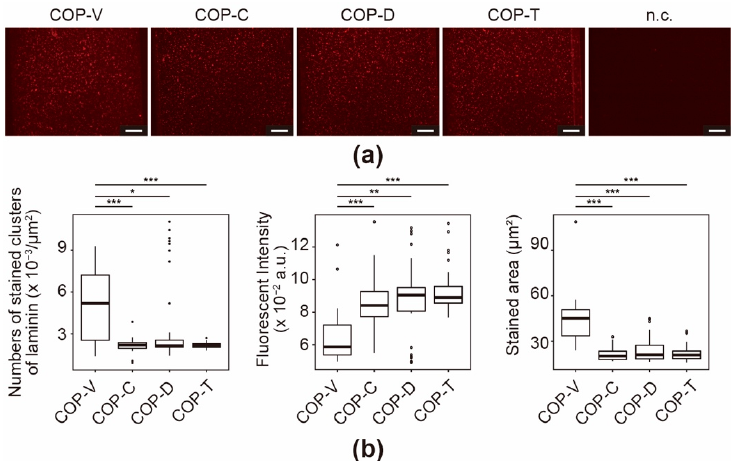
Figure 7. Immunofluorescence for laminin in Matrigel-coated cyclo-olefin polymer (COP) microfluidic channels. ( a ) Micrographs of immunostained laminin in Matrigel-coated COP microfluidic channels processed using vacuum ultraviolet (VUV)-photobonding (COP-V) or solvent-bonding with cyclohexane (COP-C), toluene (COP-T), or dichloromethane (COP-D). n.c. represents the negative control of a COP-V microfluidic channel coated with Matrigel, and only stained with a secondary antibody. The scale bars represent 100 µm. ( b ) Quantitative analyses of immunostained laminin in the Matrigel-coated COP microfluidic channels. The center lines represent the median values; the box limits indicate the 25th and 75th percentiles; the whiskers extend to 1.5-times the interquartile range from the 25th and 75th percentiles; and outliers are represented by dots. Each experiment was repeated four times, and more than ten images of the COP devices from each experiment were used for quantification. * p < 0.05, ** p < 0.01, *** p < 0.005.